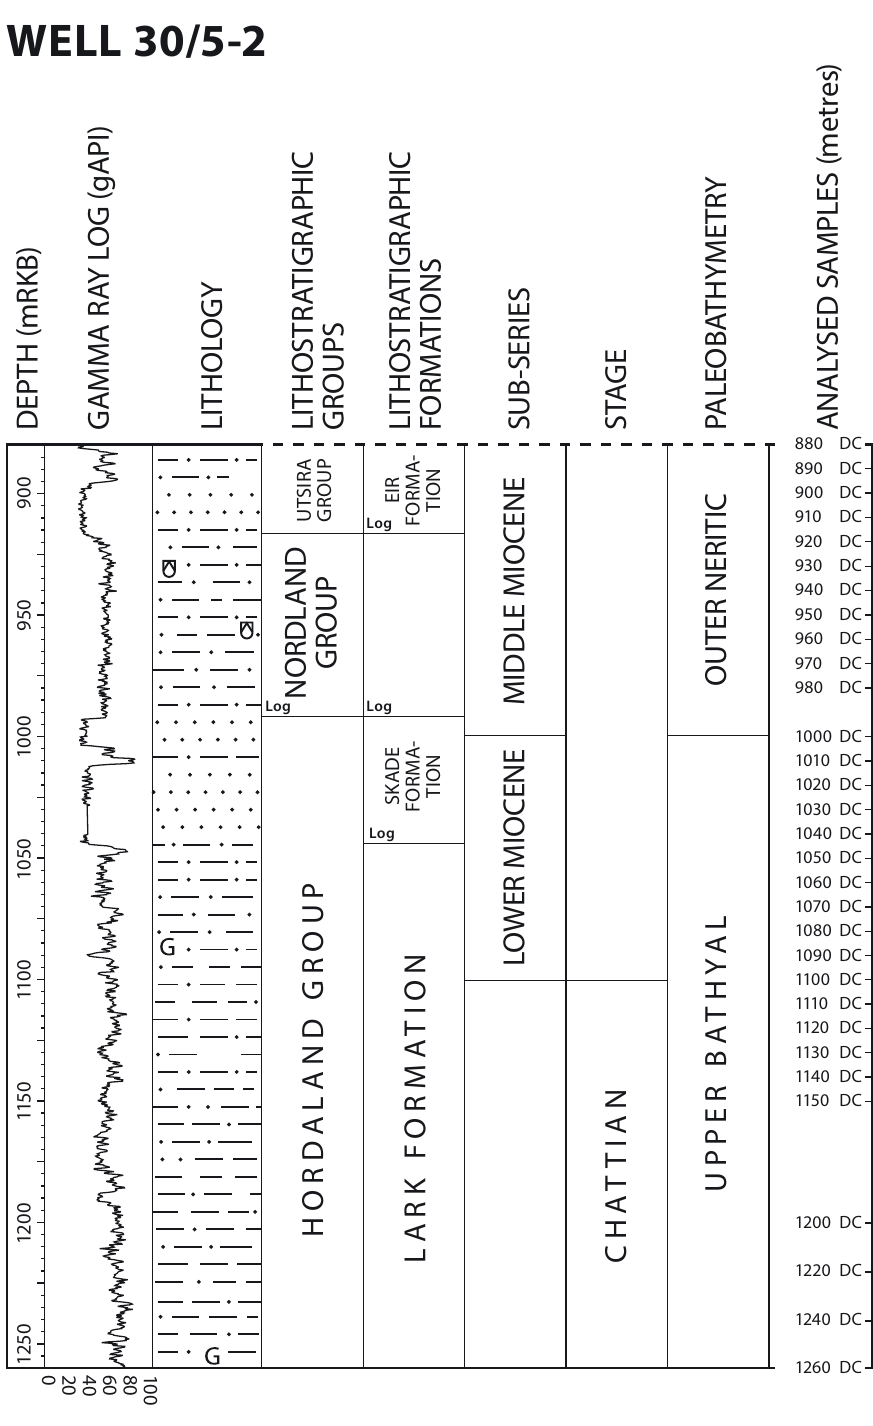
Figure 52. Well summary figure including gamma-ray log, lithology, lithostratigraphic units, sub-series, stage, paleobathymetry and analysed samples for the lower part of the investigated sequence in well 30/5–2 (Chattian to middle Miocene) including the well reference section for the Eir Formation (lower part; modified after Eidvin et al.,